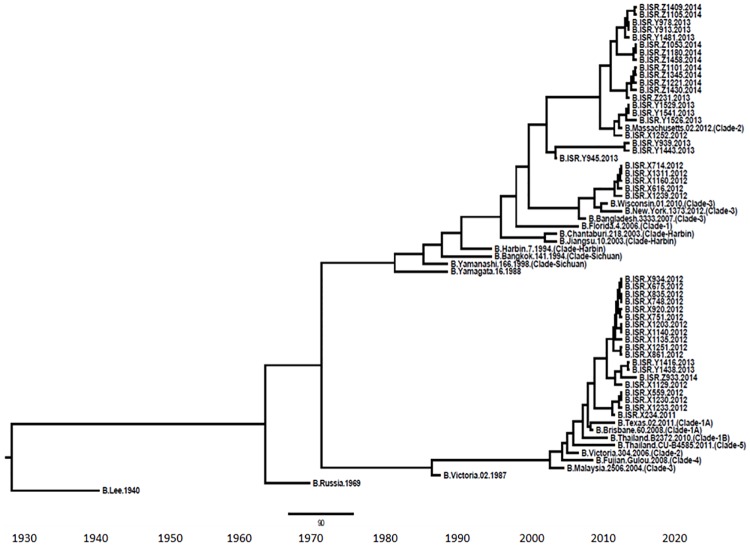
Phylogenetic tree.Bayesian maximum-clade-credibility time-scaled phylogenetic tree (BEAST) generated using 74 partially sequenced influenza B HA gene (476 bp), obtained from patient samples collected between 2012 and 2014 in Israel.